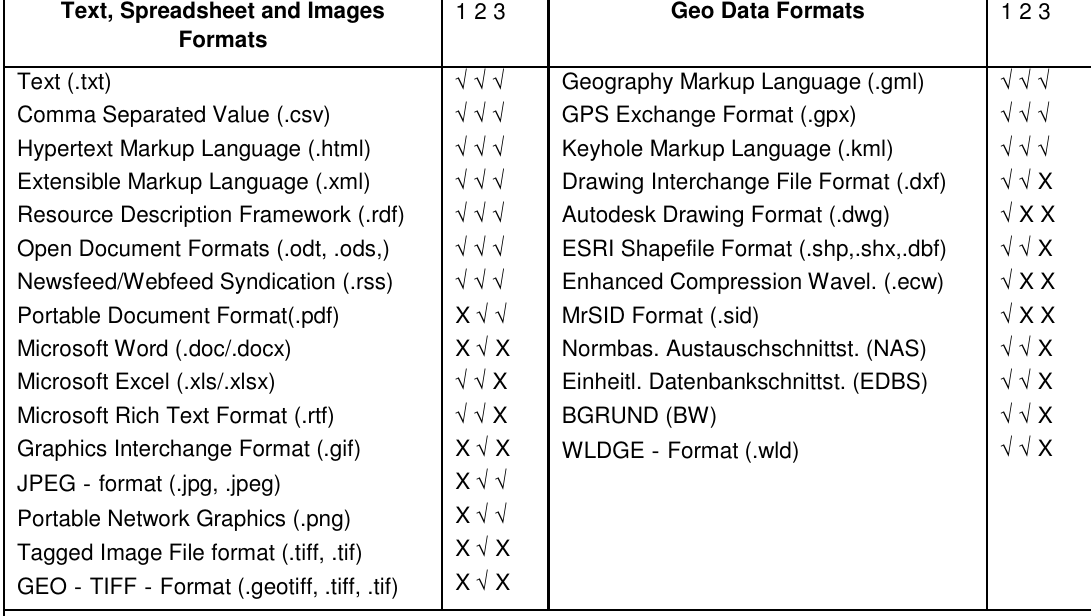
Table 1: Different Types of Formats (Gray, 2009, p.10; supplemented and adopted by von Lucke/Geiger 2010, p.9) Text, Spreadsheet and Images 1 2 3 Geo Data